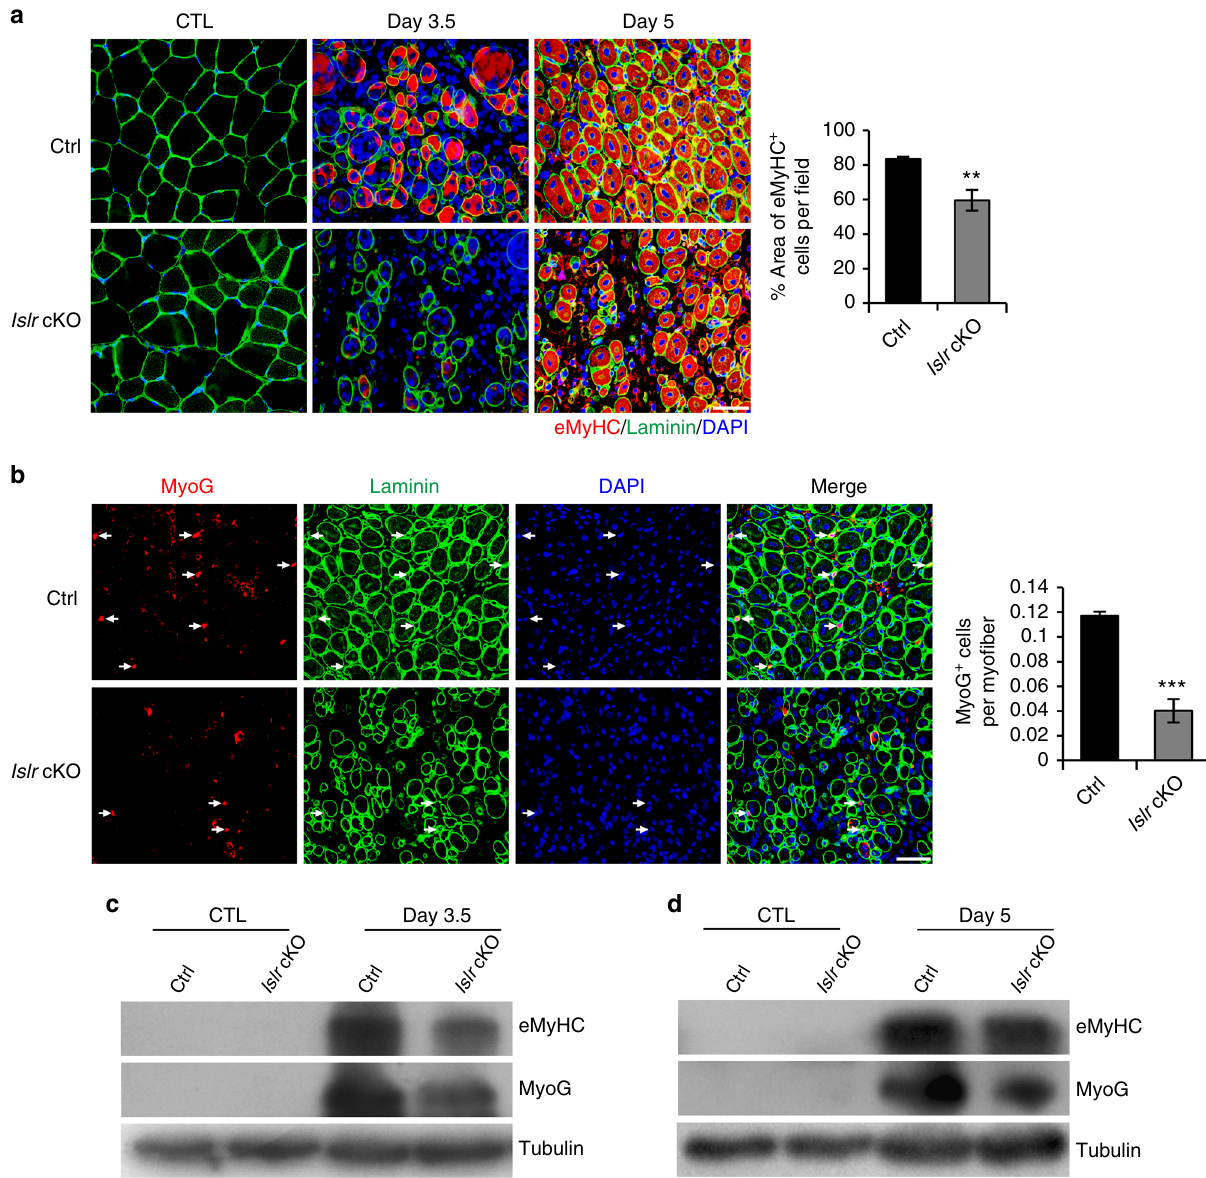
Fig. 3 Absence of satellite cell differentiation in regenerating TA muscles of Islr cKO mice. a Immuno fl uorescence analysis of eMyHC + fi bers in TA muscles of control and Islr cKO mice at 3.5 ( N = 3) and 5 ( N = 3) d postinjury. The percentage of area occupied by eMyHC + fi bers per fi eld at 5 d postinjury is shown on the right. b Immuno fl uorescence analysis of MyoG + cells in TA muscles of control and Islr cKO mice at 5 d post injury. N = 3 in each group. The number of MyoG + cells per myo fi ber is shown on the right. c Western blot analysis of eMyHC and MyoG protein levels in control and Islr cKO mice at 3.5 d postinjury. d Western blot analysis of eMyHC and MyoG protein levels in control and Islr cKO mice at 5 d postinjury. Scale bars are all 50 μ m. Error bars represent the means ± s.d. ** P < 0.01, *** P < 0.001; Student ’ s t